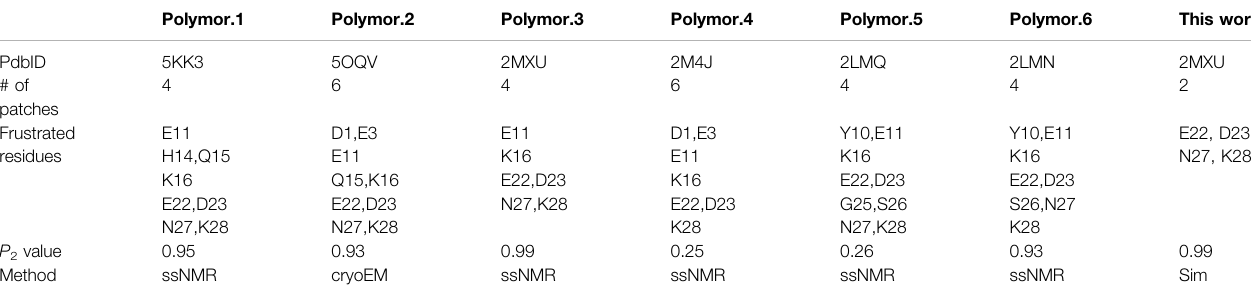
TABLE 2 | Polymorphic properties of